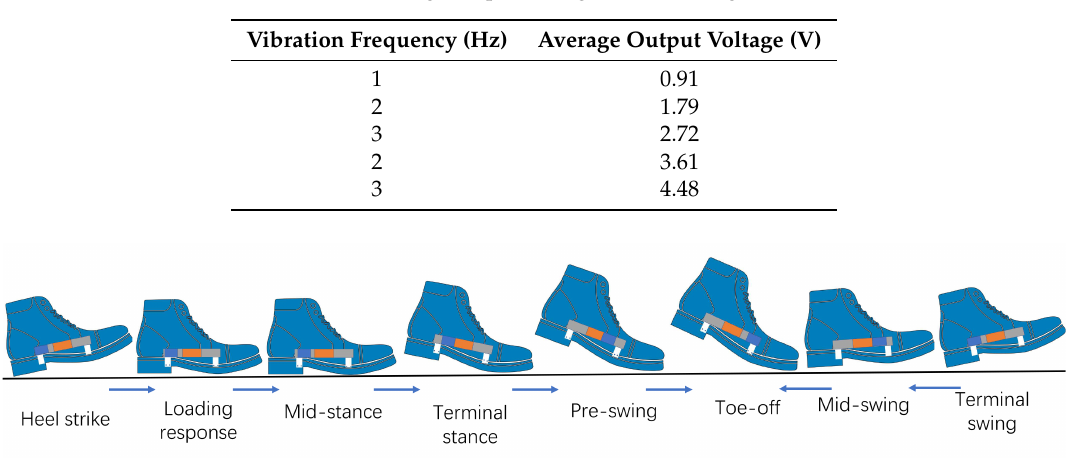
Figure 3. The average output voltage and current of vibration are measured at different vibration frequency (1–5 Hz). Table 3. The average output voltage of vibration generator.